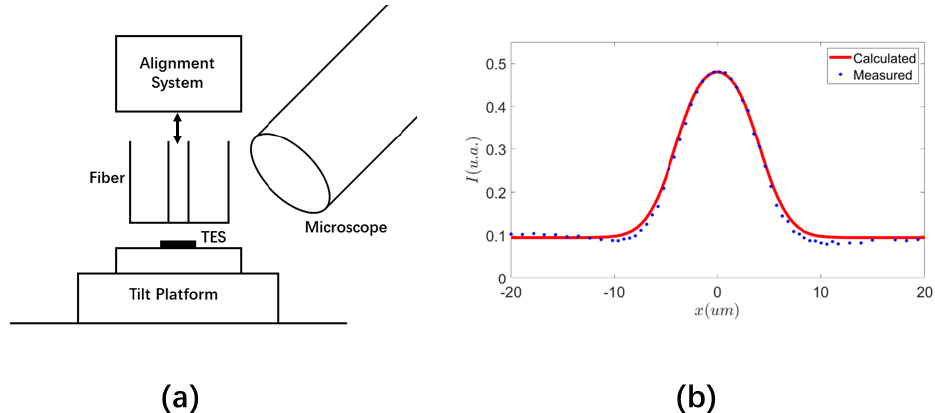
Figure 9. Alignment of a TES by reflected wave intensity measurement. ( a ) Alignment setup for the TES device. The fiber is connected to the alignment system in Figure 1a. It is also attached to an (unshown) 3-axis translation stage to adjust its position relative to the sensor chip. ( b ) Comparison of experimentally measured reflected wave intensity and numerically calculated curve, against misalignment along the midline of a 10 µ m × 10 µ m TES device, representative of the degree of agreement between experimental and numerical results. The ratio between the amplitude reflection coefficient on the device and substrate is measured to be